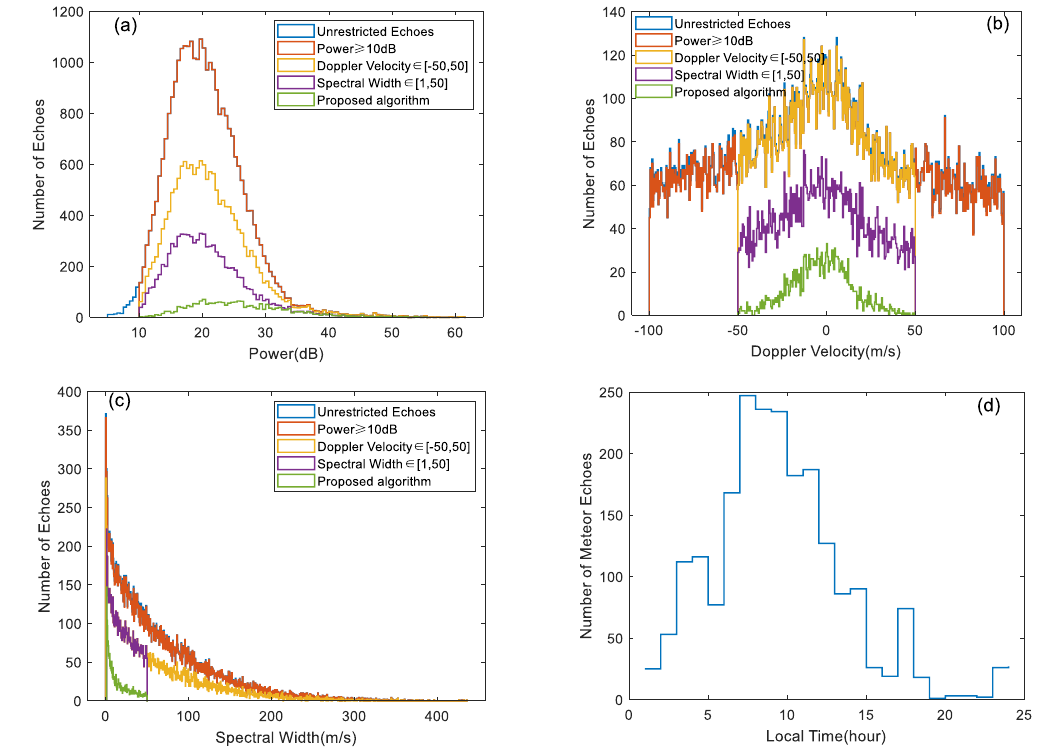
Figure 5. Histogram of meteor echo distribution extracted using Table 4 parameters. ( a ) Backscatter power distribution, ( b ) LOS Doppler velocity distribution, ( c ) Spectral width distribution, ( d ) The time distribution of number of meteor echoes in 24 h.